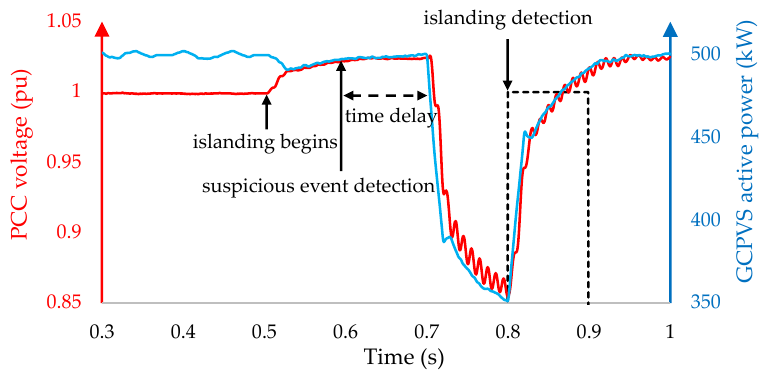
Figure 7. Results of islanding events under Q f =1.5.